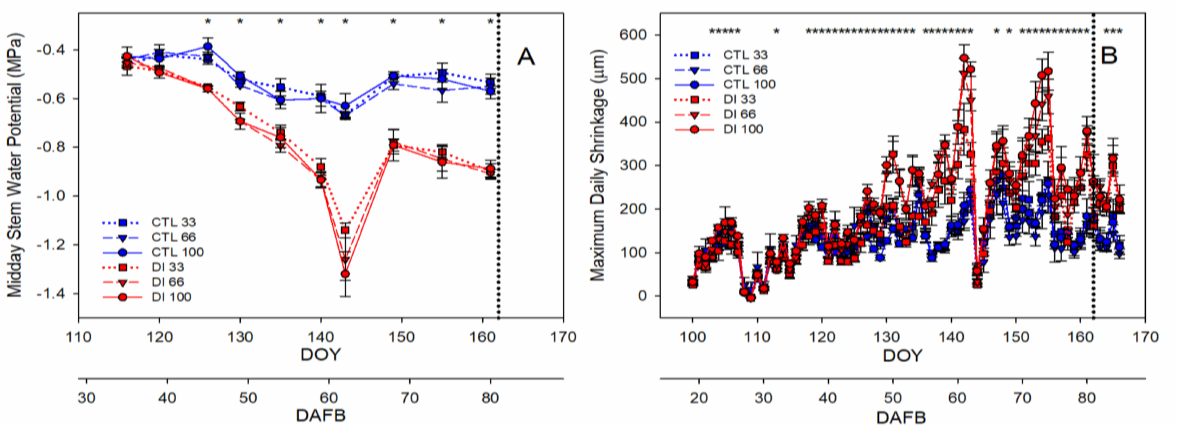
Figure 3. Seasonal evolution of midday stem water potential ( A ) and maximum daily branch shrinkage ( B ) for the two irrigation treatments: CTL (full irrigated treatment; blue) and DI (deficit irrigation treatment; red), and the three levels of crop load: low (33%, squares), medium (66%, triangle), and high (100%, circle). Each point is the mean ± SD of three trees. Asterisks indicate significant differences between CTL and DI, according to ANOVA ( p < 0.05). The vertical dotted line indicates the harvest day (day of year, DOY 162; days after full bloom, 81 DAFB). Full bloom: 22 March 2019; harvest day: 11 June